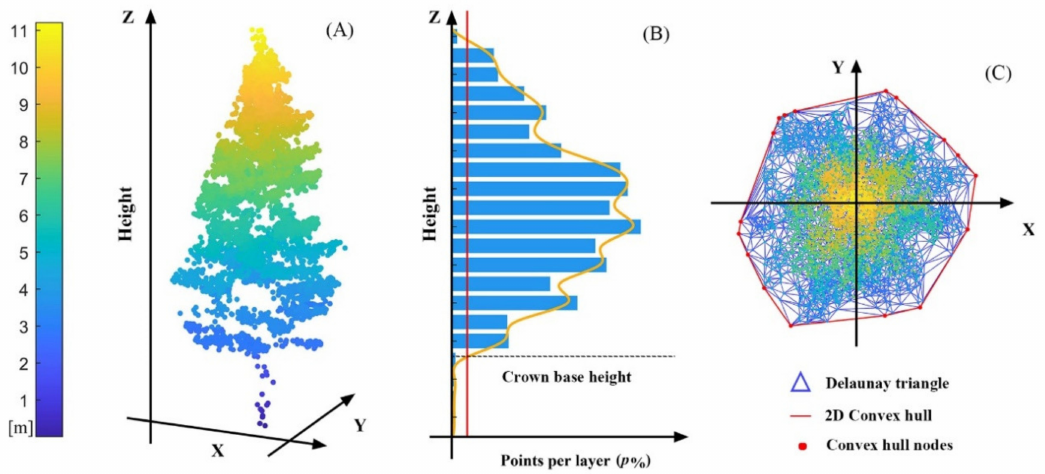
Figure 4. ( A ) Individual tree point clouds, ( B ) determination of the crown base height, and ( C ) the vertical projection of the crown for crown width